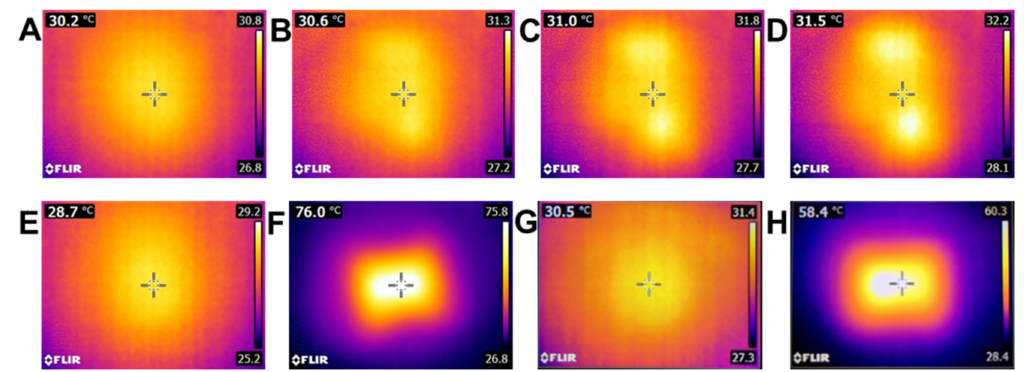
Figure 11. Representative images of temperatures reached by polymeric films with and without GnRs, irradiated with the near-infrared NIR laser. Control film, room temperature and no irradiation ( A ). Control film after 10 s of irradiation ( B ). Control film after 20 s of irradiation ( C ). Control film after 30 s of irradiation ( D ). CTAB-GnRs film, no irradiation ( E ). CTAB-GnRs film irradiated for 15 s ( F ). PEG-GnRs film, no irradiation ( G ). PEG-GnRs film irradiated for 15 s ( H